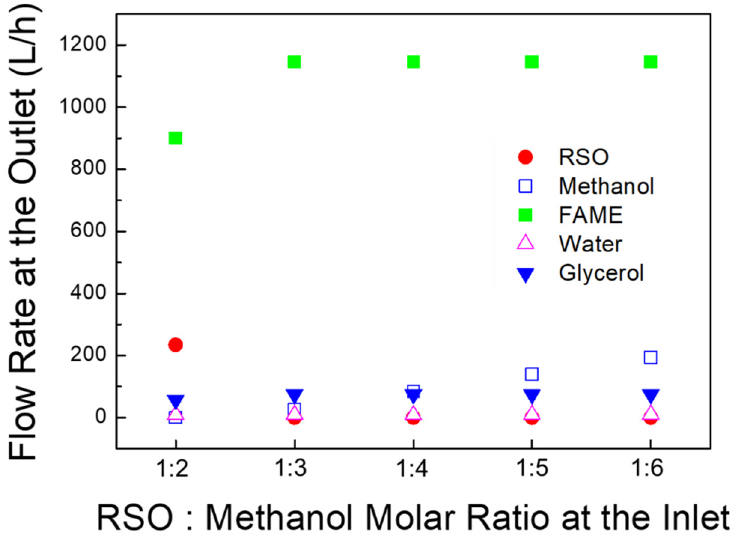
Figure 5. Effect of RSO to methanol ratio on the flow rate of each reactor product.